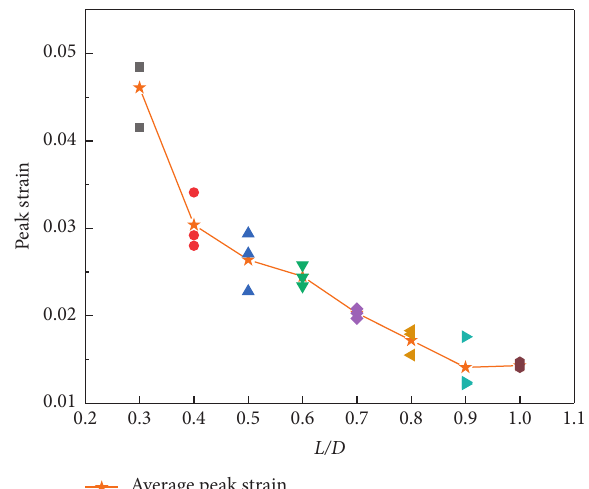
Figure 8: Changing curve of the peak strain with the L / D ratio.